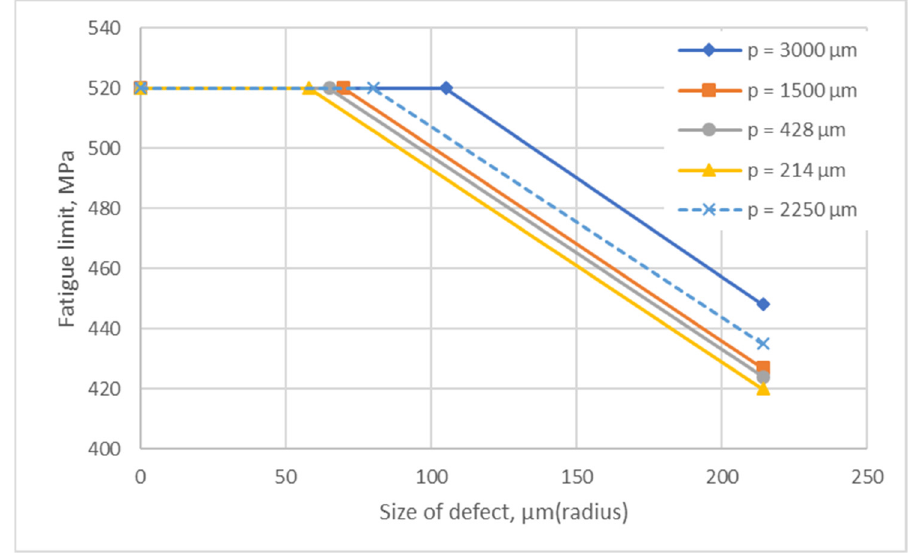
Figure 13. Kitagawa diagram for different defect sizes.